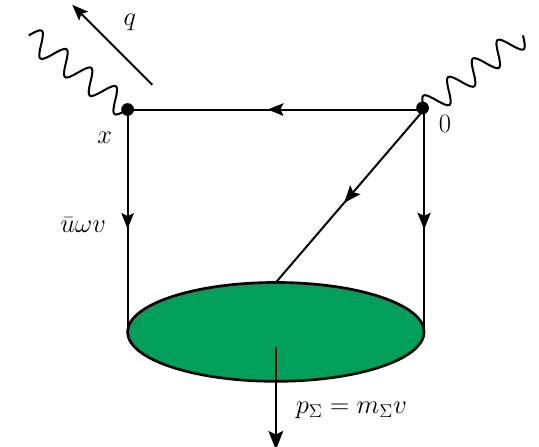
Fig. 1 Feynman diagram of the QCD level correlation function. The green ellipse denotes the final (cid:3) Q (cid:2) baryon with four-velocity v . The left black dot denotes the V − A current while the right dot denotes the doubly-heavy baryon current. The left straight line denote one of the light quark inside the (cid:3) Q (cid:2) . It has momentum ¯ u ωv , where ¯ u is its momentum fraction of the diquark